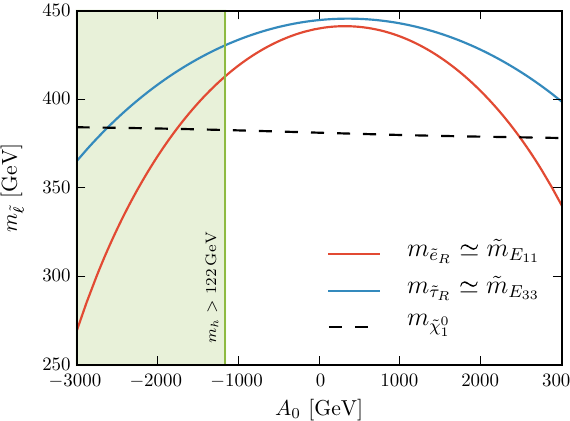
Fig. 1 Dependence at one-loop of the stau, selectron and lightest neu- tralino mass on the initial choice of A 0 at M X for λ 231 | M well as M 0 = 300 GeV, M 1 / 2 = 900 GeV and tan β = 10. The green shaded area indicates the region where the Higgs mass is sufficiently heavy, m h > 122GeV, see text